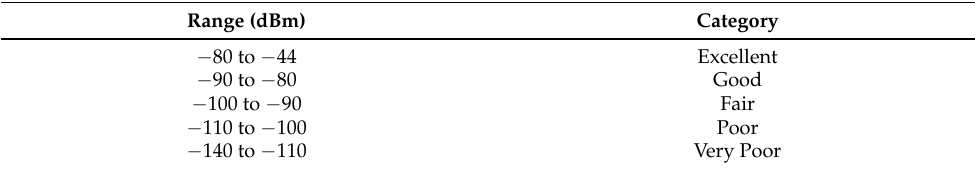
Table 9. Performance indicator standards for RSRP